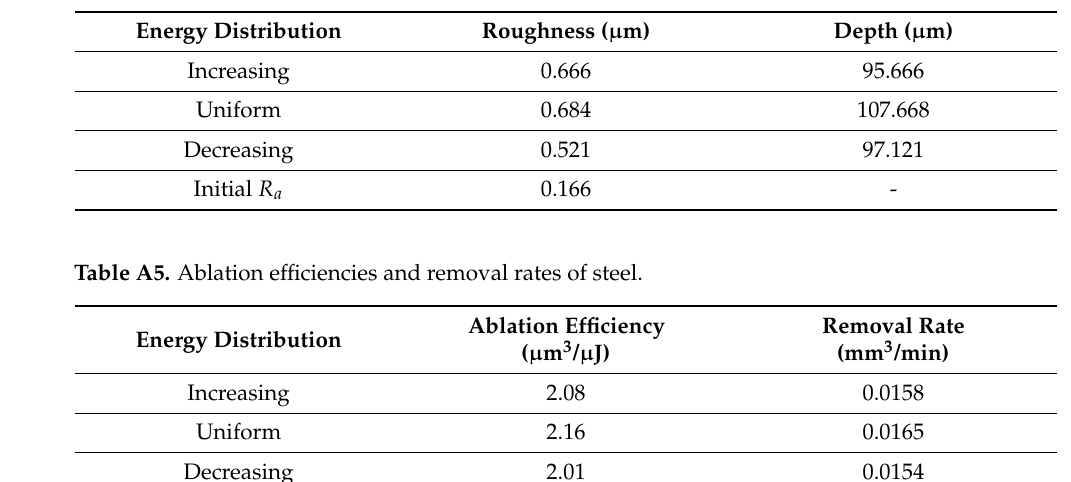
Table A4. Roughness and depth of silver.